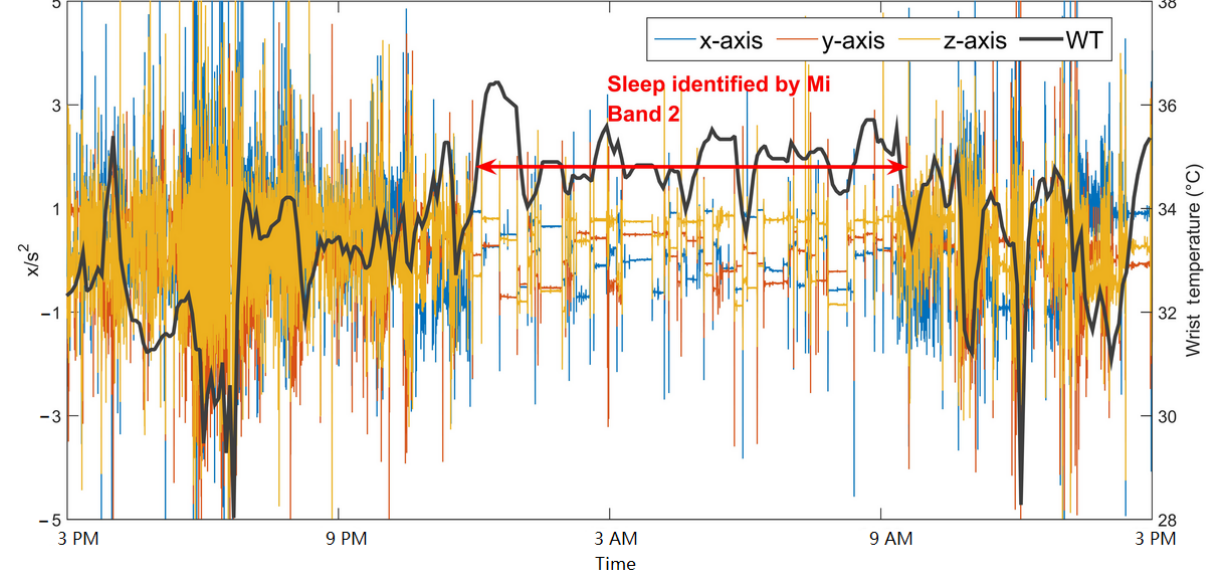
Figure 5. Example wrist temperature and AX3 data for a healthy younger adult with good sleep (YA1). Sleep onset and offset detected by Mi Band 2 are indicated by the double red arrows. WT: wrist temperature.